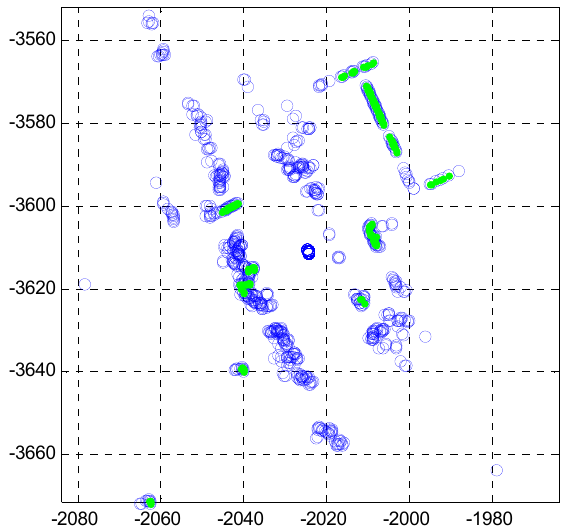
Figure 6. Line extraction result (after outlier removal).